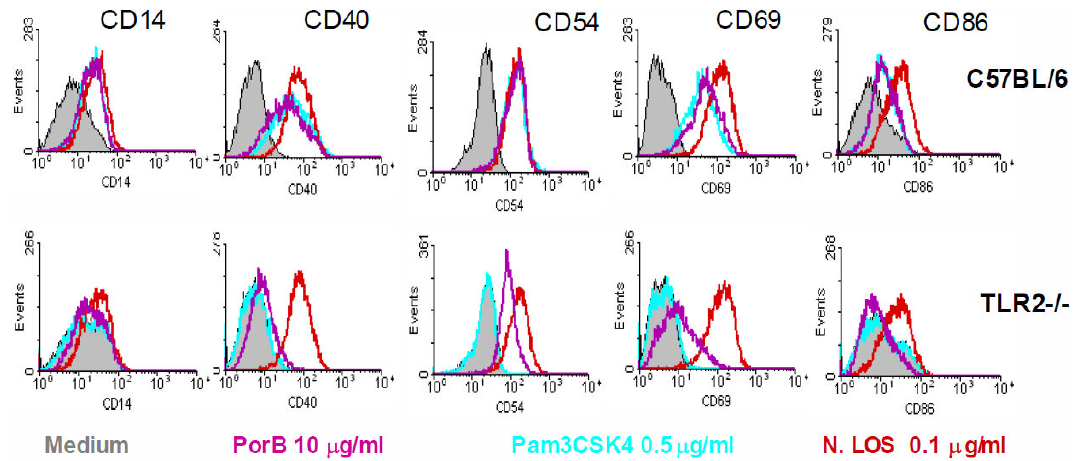
Figure 2. Upregulation of co-stimulatory cell-surface proteins by PorB is partially TLR2 dependent. WT and TLR2 KO BMDMs were stimulated in culture with PorB, Pam3CSK4 or LOS, then stained for markers of activation and examined by flow cytometry. In WT cells, PorB increased surface expression of CD14, CD40, CD54, CD69 and CD86 as compared to unstimulated cells. Knockout cells had decreased expression of CD14, CD40 and CD86, but still had higher expression of CD54 and CD69 when compared to basal levels. In the latter two cases, the TLR2 ligand Pam3CSK4 had no effect on TLR2 -/- cells. Histograms are from one representative sample of at least 3. Data represents one of two experiments.